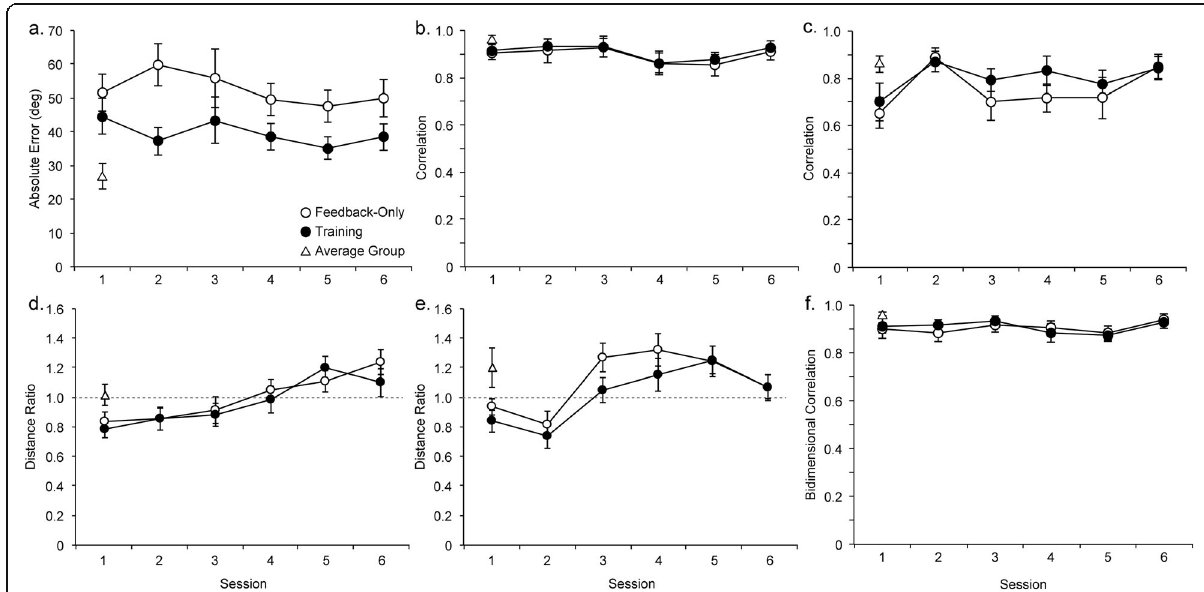
Fig. 4 Results of a mixed analysis of variance for direction estimates ( a ), distance correlations for route distances ( b ) and straight-line distances ( c ), distance ratios for route distances ( d ) and straight-line distances ( e ), and sketch maps ( f ). Correlations for distance estimates and sketch maps are shown in terms of r . Values transformed into Fisher ’ s z were analyzed. The average group estimated directions and distances and drew sketch maps for the first route (their performance is shown by triangles). Vertical lines depict standard errors of the